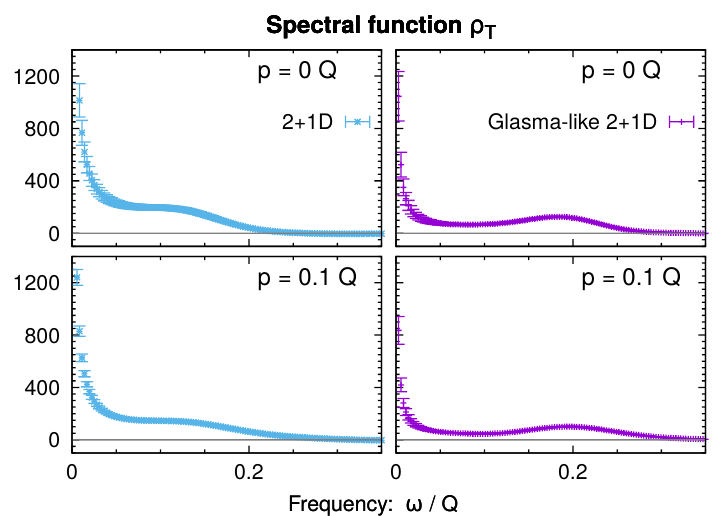
Figure 8 . Transverse spectral function ρ T computed as ˙ ρ T /ω for small momenta p = 0 Q and p = 0 . 1 Q as a function of ω for 2+1D (left) and Glasma-like 2+1D (right) theories. Due to its symmetry, the spectral function satisfies ρ ω → 0 due to the finite values of ˙ ρ T